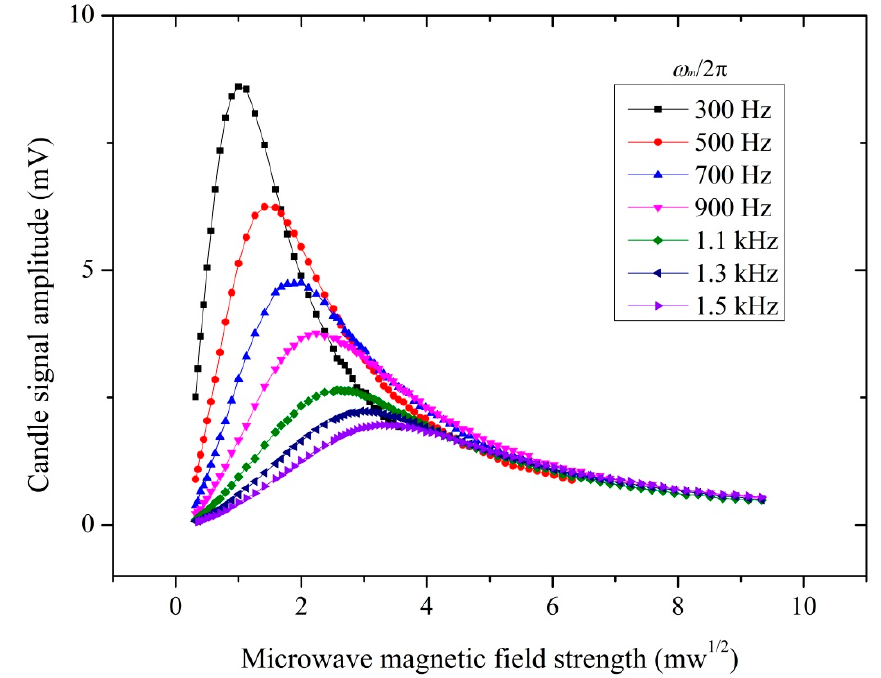
Figure 3. Atomic candle signal at phase-modulating frequencies of ω m /2 π (300 Hz, 500 Hz, 700 Hz, 900 Hz, 1.1 kHz, 1.3 kHz, and 1.5 kHz). The detected signal was analyzed by the FFT analyzer. Vertical axis values of the plots were the peak value of the laser absorption signal observed by FFT analyzer. Horizontal axis values were observed in microwave signal source. These curves were measured at different microwave phase-modulating frequency. What we focus are the horizontal axis values of the atomic candle signal peak. The signal peak values were increased with the microwave phase-modulating frequency. The diameter of the laser spot was 3 mm and the laser intensity was 85 µ W/cm 2 . The phase modulation index of θ was set 2.3 rad. The measurement distance was 20 mm.